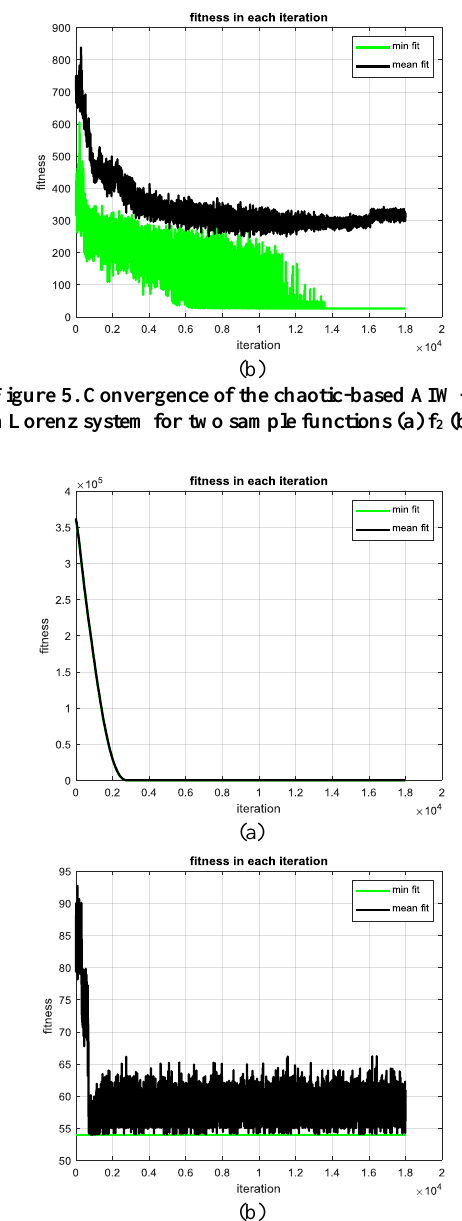
Figure 6. Convergence of the chaotic-based AIW-PSO with Henon map for two sample functions (a) f2 (b)